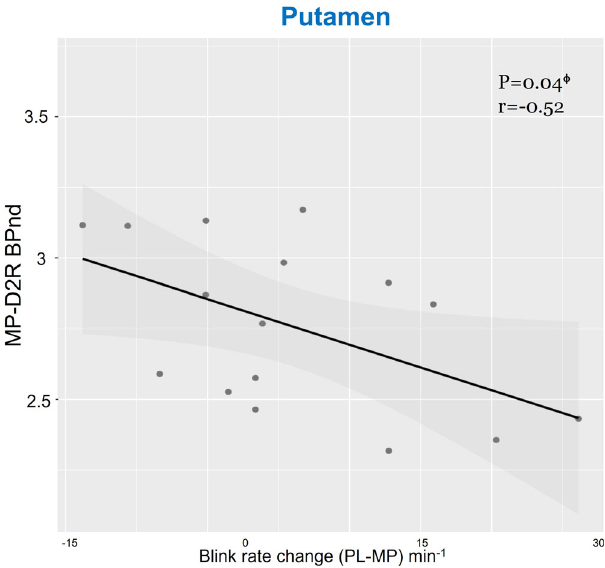
Fig. 5 MP-induced EBR changes (PL-MP) were negatively correlated with MP-D2R in putamen. MP-induced EBR changes (PL-MP) were negatively correlated with MP-D2R in putamen but not in caudate or VS. Participants with low MP-D2R in putamen reduced EBR with MP whereas those with high MP-D2R increased EBR. ( n = 16). Shaded area indicates 95% Con fi dence Interval (CI). Each points represents a value from each marginal for putamen (F(3,12) = 3.018, R 2 = 0.43, p = 0.071, where the effect of BL-D1R was signi fi cant β = − 0.484, p < 0.05). Model was not signi fi cant for VS.